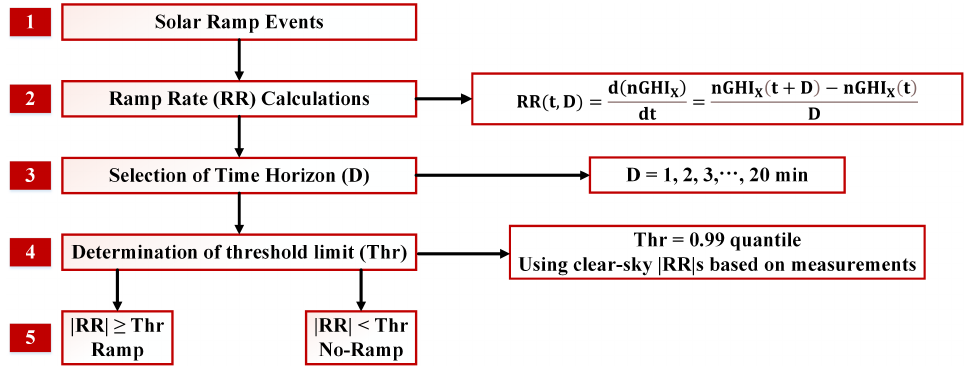
Figure 1. Flowchart of the applied methodology.